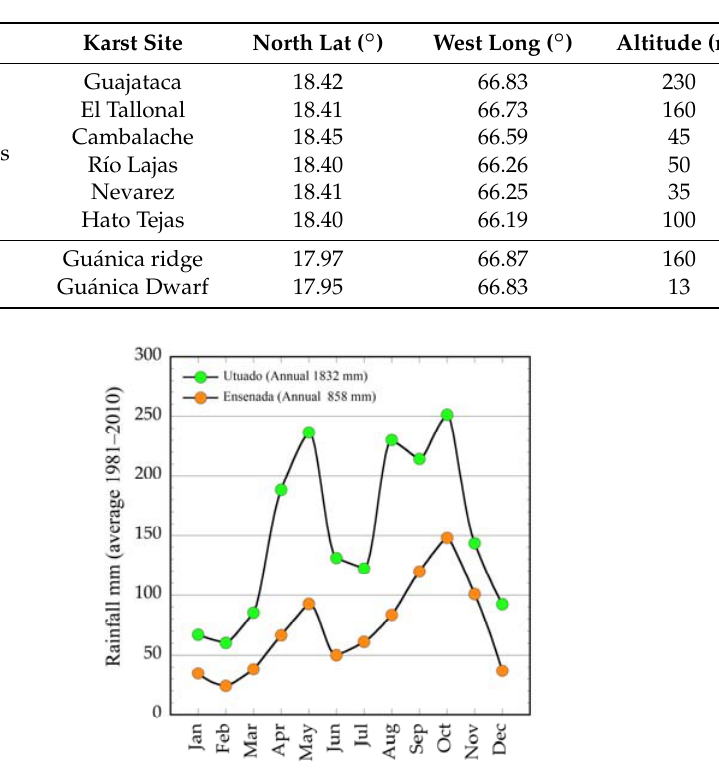
Table 1. Karst site locations (Lat, Long) and approximate altitude.